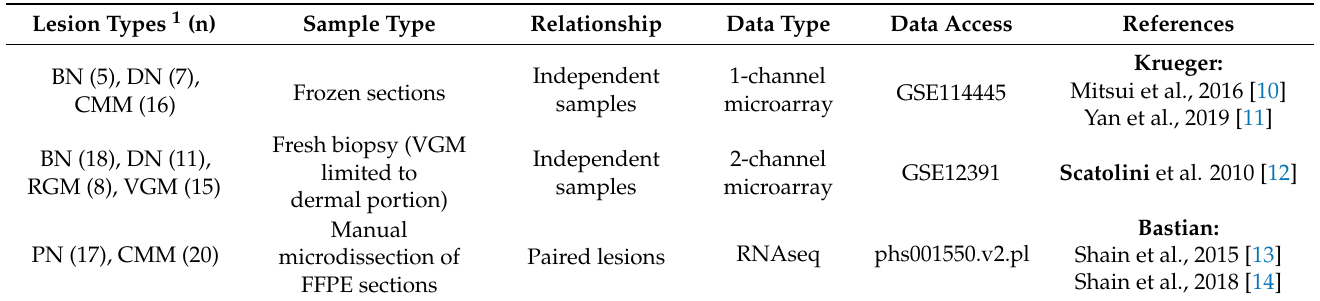
Table 1. Three available datasets with dysplastic or progressing nevi and